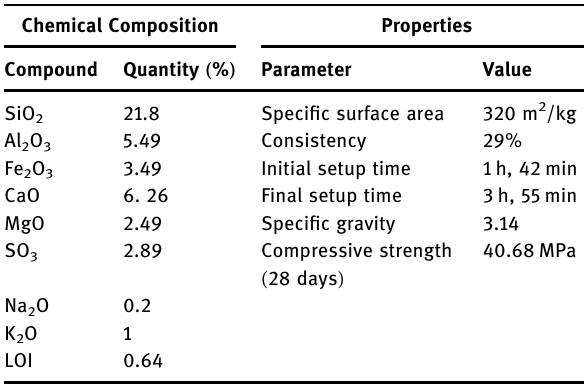
Table 1: Chemical composition and properties of